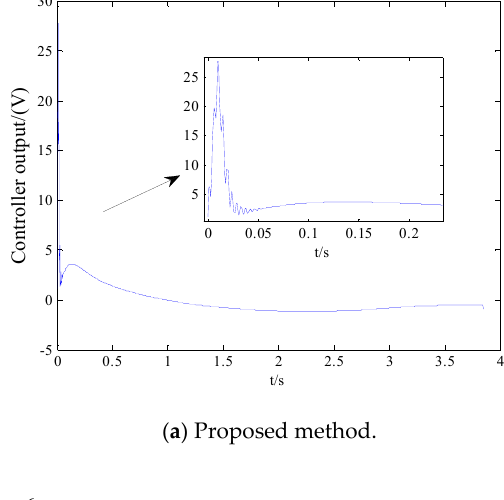
Figure 11. Total disturbance estimated by adaptive RBFNN.